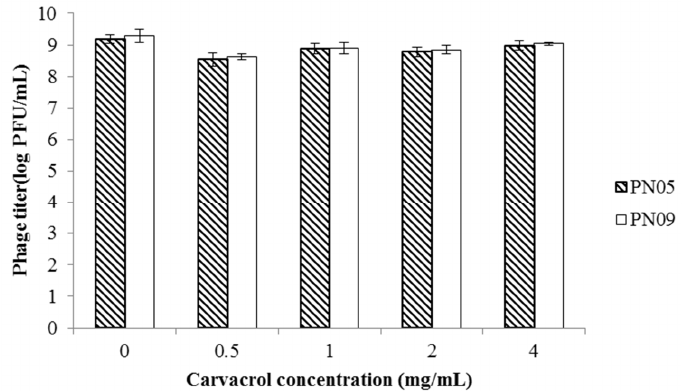
Figure 1. Phage sensitivity to carvacrol. The sensitivity of the phages to the indicated concentrations of carvacrol was evaluated after a 24-h incubation at 4 °C. Data are the mean ± standard deviation of three independent assays.